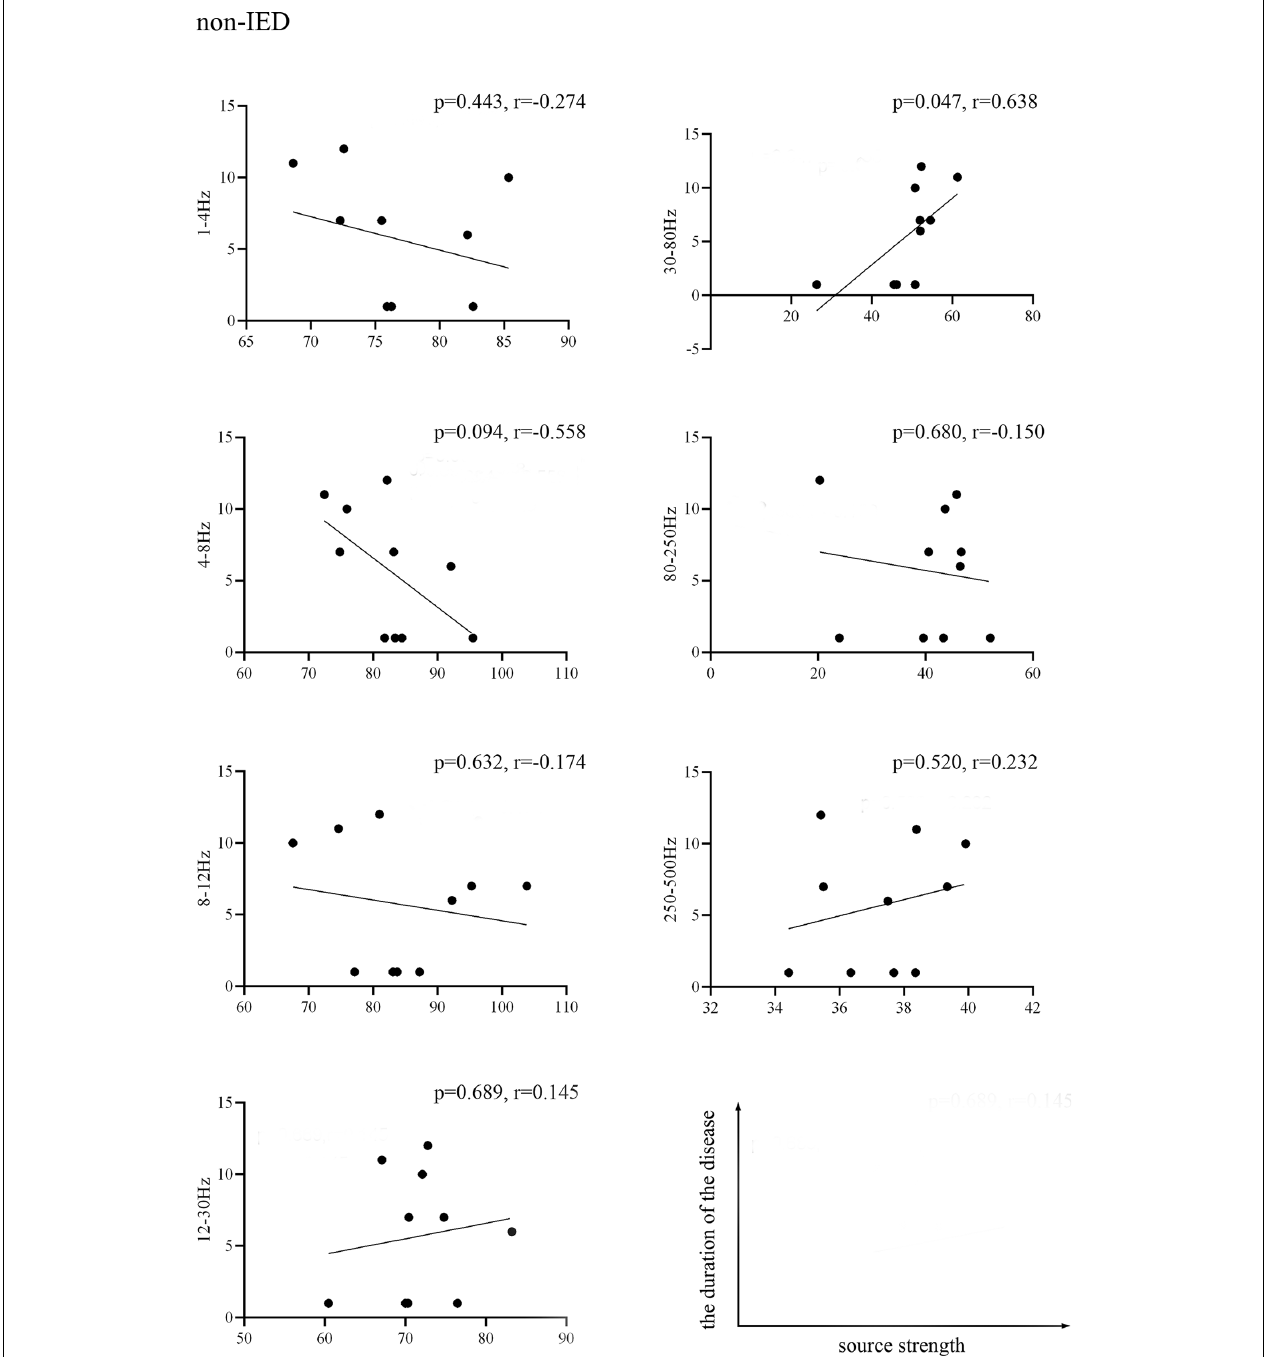
FIGURE 3 | Pearson’s correlation showing the relationship between the source strength of the non-IED group activities and the duration of epilepsy. Source strength was found to be positively correlated with the duration of epilepsy in the 30–80 Hz band ( p < 0.05, r = 0.638). Correlation between the two variables is plotted in the sample coordinate (last row) with source strength as abscissa and the duration of the disease as